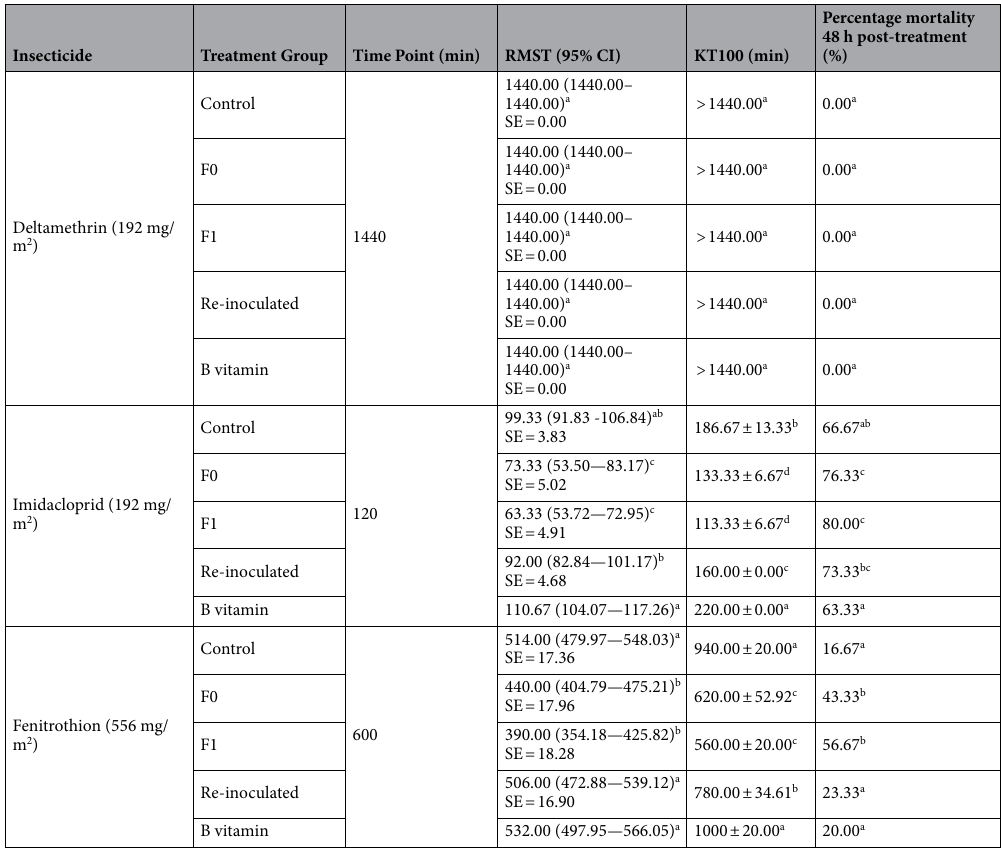
selected, and the selected sequences were trimmed based on the length of primers (forward: 17 bp; reverse: 21 bp) and truncated to 270 bp and 250 bp respectively. A total of 273,061 high quality reads were obtained after